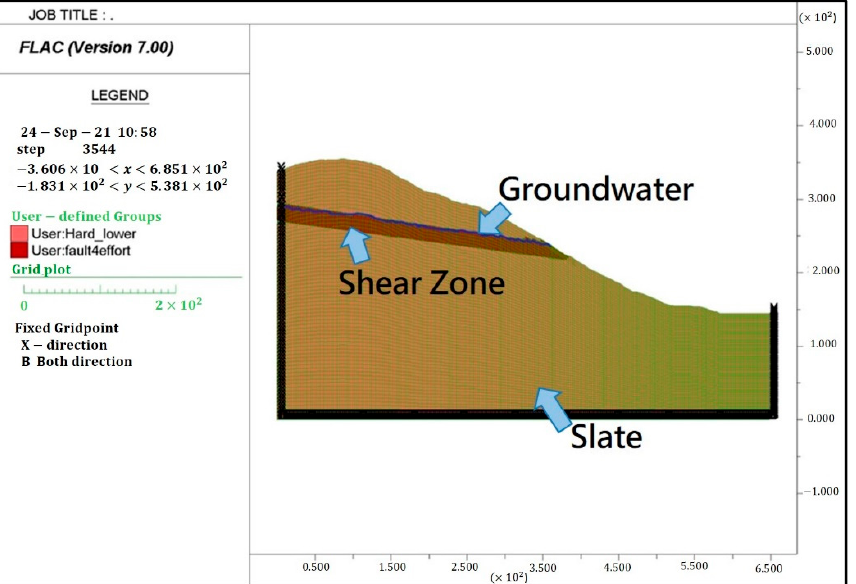
Figure 15. The slope model of profile X-X’, with the ground layers of rock material (slate) and shear zone. Location of the ground water table is also indicated.